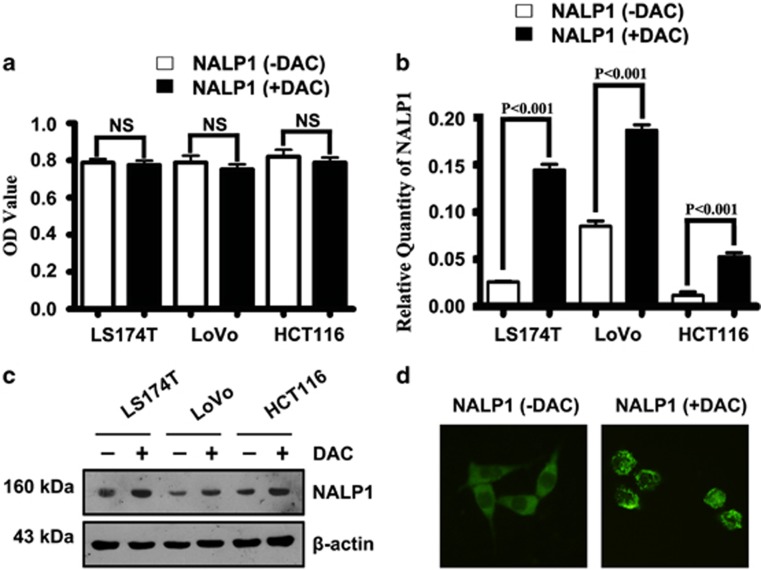
Expression of NALP1 in colon cancer cell lines before and after DAC treatment. (a) The cytotoxicity of DAC in vitro. No cytotoxicity was observed in any of the three cell lines at 1.0 μM DAC. (b) Expression of NALP1 mRNA relative to GAPDH in three kinds of colon cancer cell lines before and after DAC treatment. (c) Western blot analysis of NALP1 protein before and after DAC treatment. (d) Representative immunofluorescence staining of NALP1 in LS174T cells (untreated with DAC, left panel; treated with DAC, right panel)